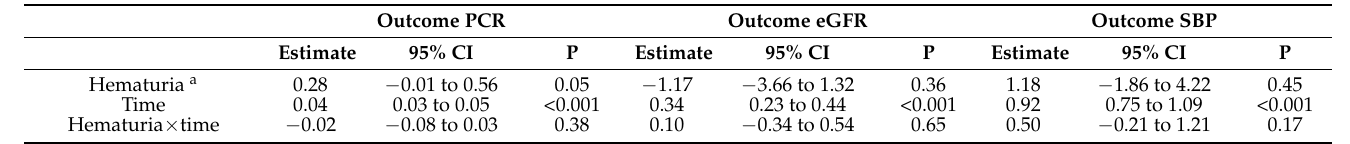
Table 2. Linear mixed model analysis of the associations between pre-donation hematuria and post-donation PCR, eGFR, and SBP over